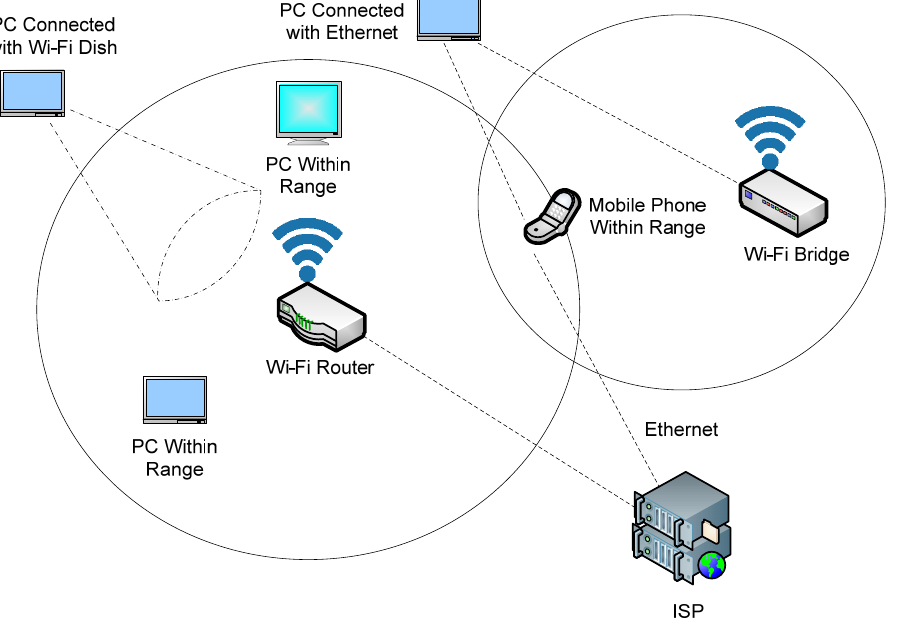
Figure 1. Generic structure of Wi-Fi hotspots.